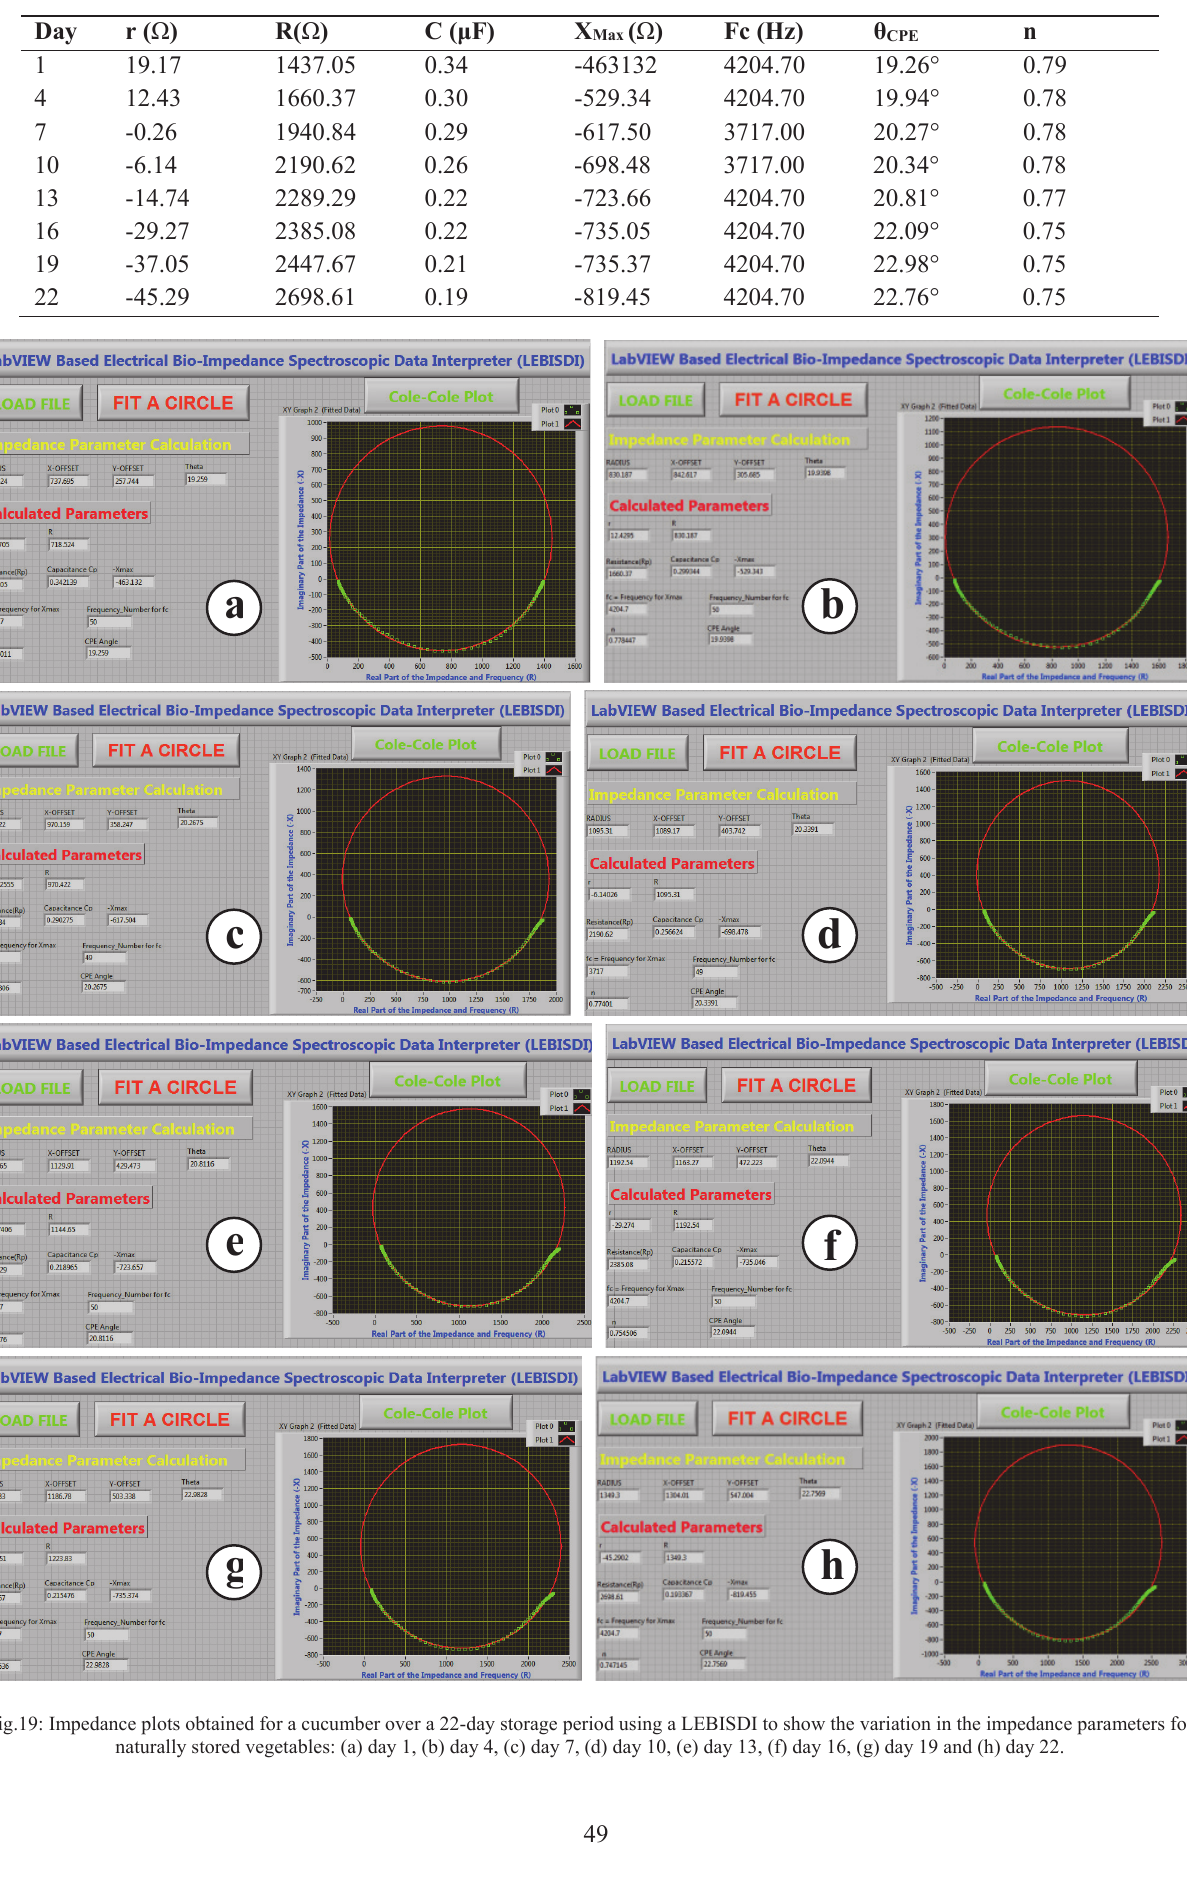
Table 7: Comparison of impedance parameters calculated from the impedance data estimation in LEBISDI for cucumber sample studied over a 22-day period.